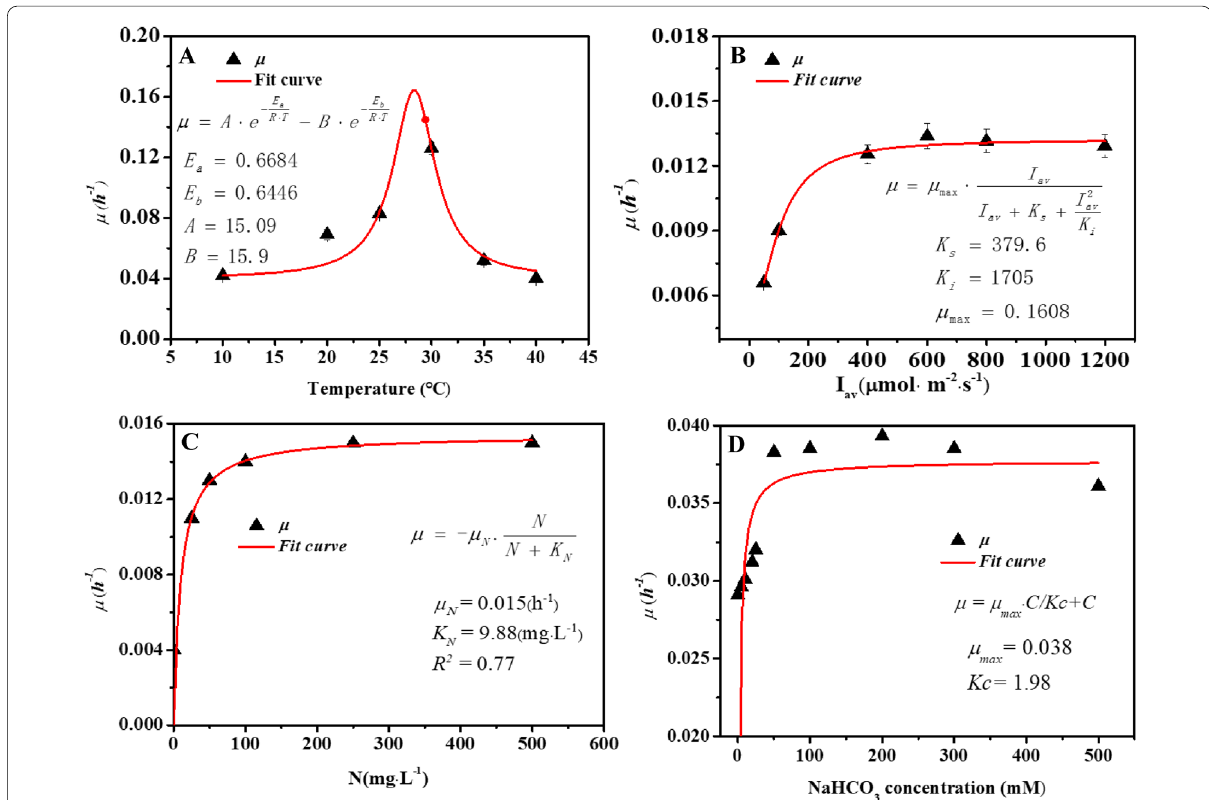
Fig. 1 Growth rate of D. salina under different culture conditions. A The relationship of temperature and cell-specific growth rate B The relationship of light intensity and cell-specific growth rate. C The relationship of nitrogen concentration and cell-specific growth rate. D The relationship of carbon concentration and cell-specific growth